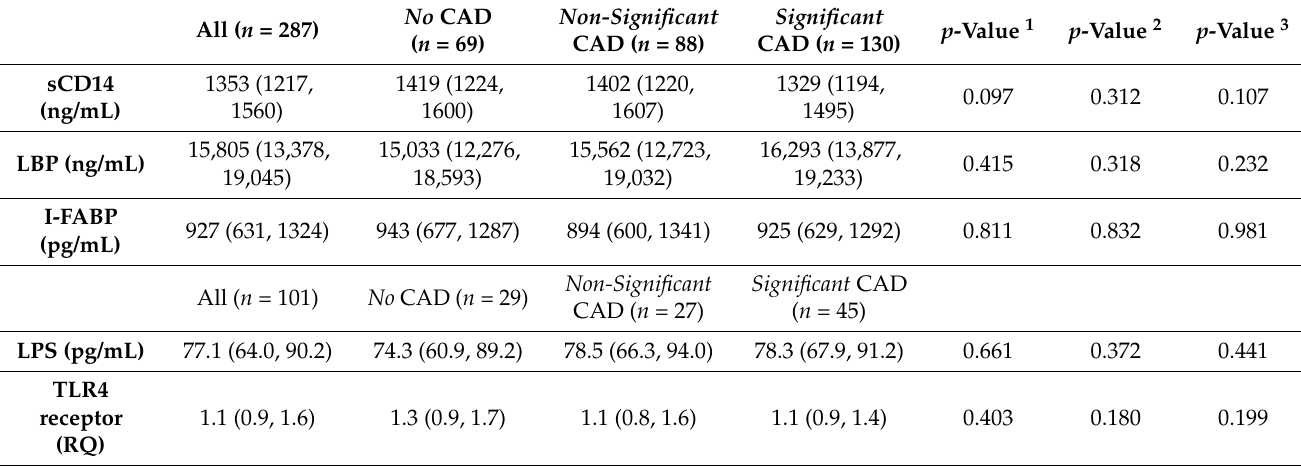
Table 3. Gut leakage markers at baseline in all patients and according to coronary artery